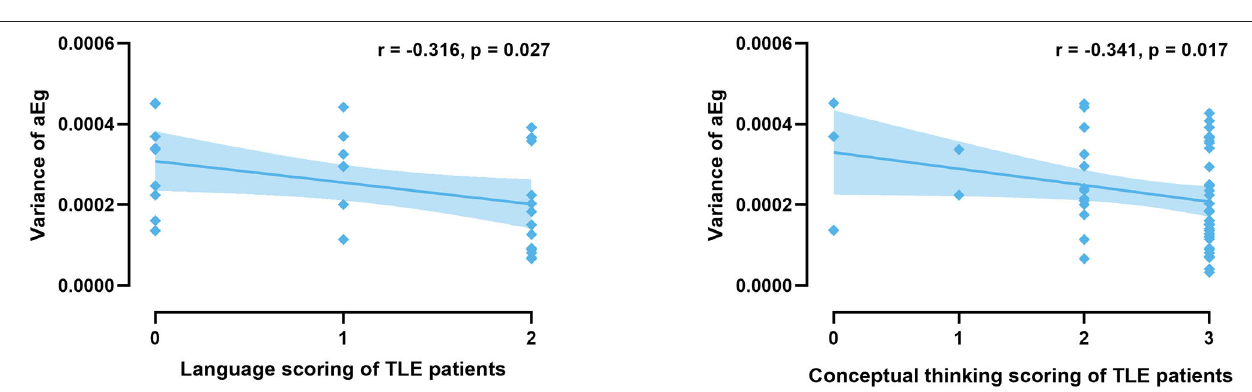
FIGURE 7 | Variability of global topological properties in dynamic functional connectivity. The left column represents the variance of small-world properties and network efficiency for the sparsity range 0.08–0.48. Straight lines show the average, and the corresponding transparent areas indicate the standard error. The right bar demonstrates the group effect of AUC. The horizontal lines above the bars indicate comparisons that achieved statistically significant thresholds (* P < 0.05, Bonferroni corrected). Gamma, normalized clustering coefficient; Lambda, normalized characteristic path length; Sigma, small-worldness index; Eg, global network efficiency; Eloc, local network efficiency.